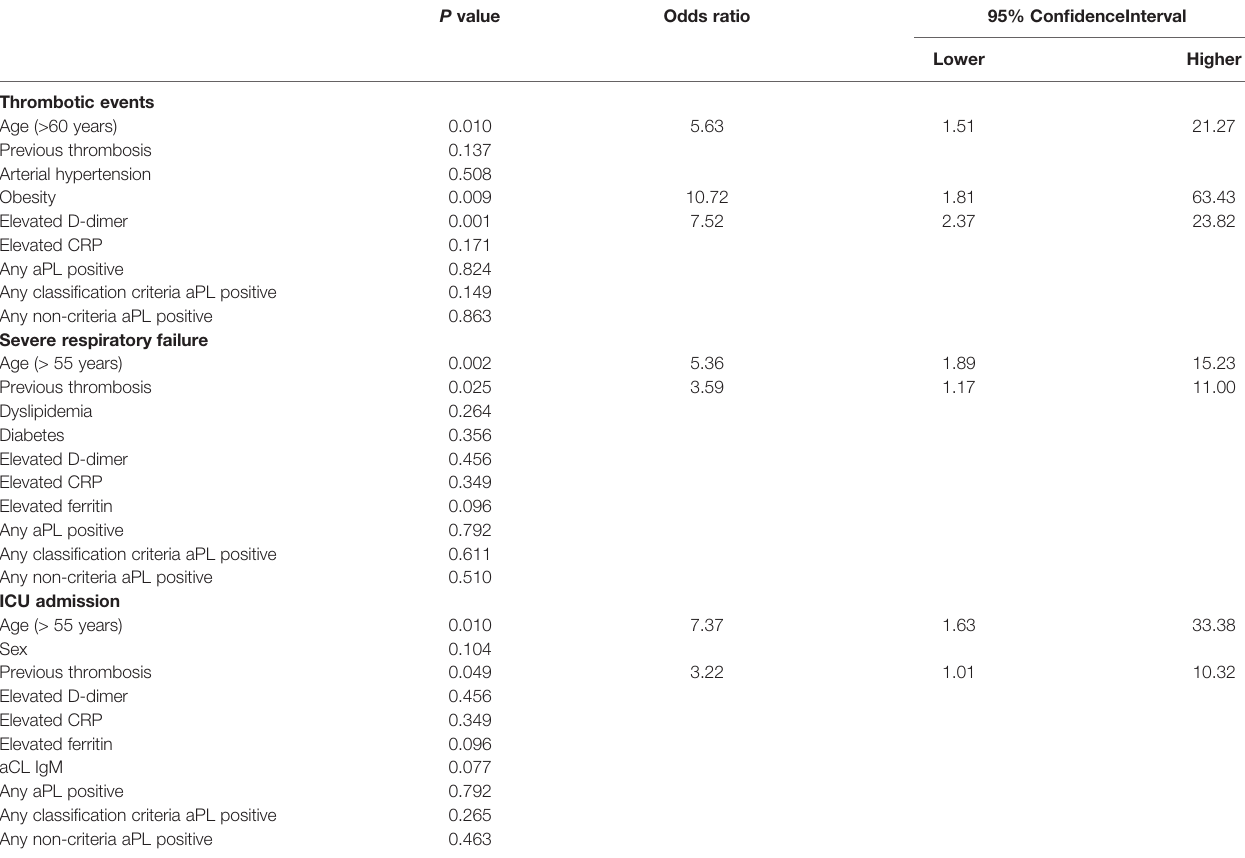
aCL, anticardiolipin antibodies; aPL, antiphospholipid antibodies; CRP, C-reactive protein; ICU, intensive care